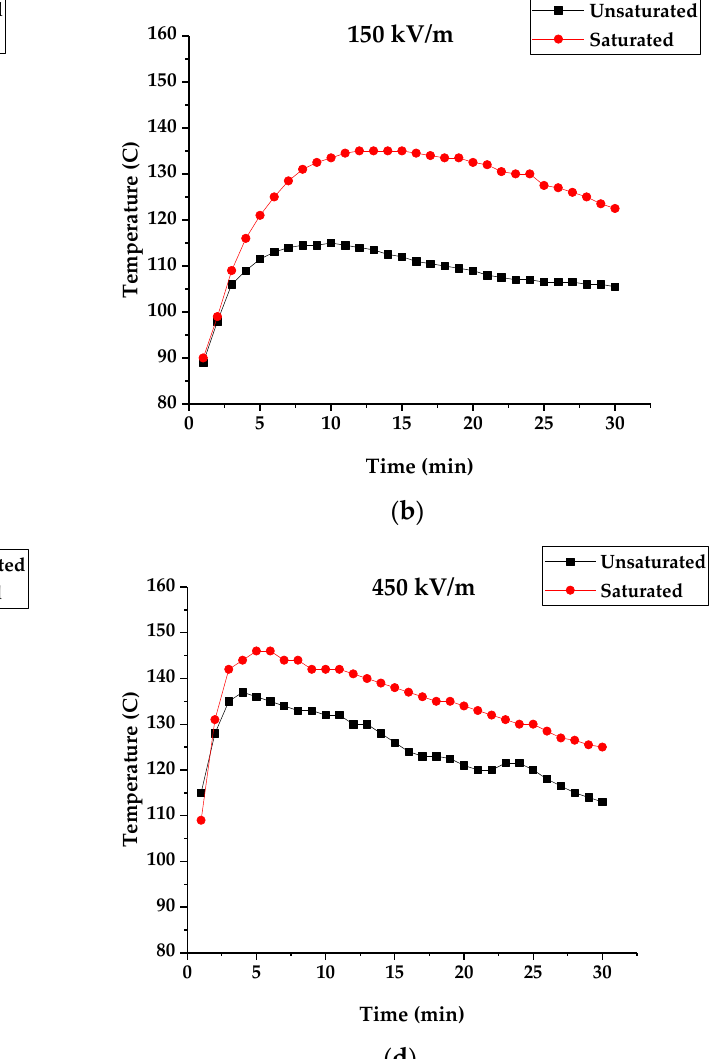
Figure 4. The difference between unsaturated contaminated soil and saturated contaminated soil based on the temperature profiles with time using various electric field intensities where ( a ) is based on RF heating treatment using 112.5 kV/m, ( b ) is obtained using 150 kV/m, ( c ) is derived from 225 kV/m, and ( d ) is based on RF heating treatment using 450 kV/m.